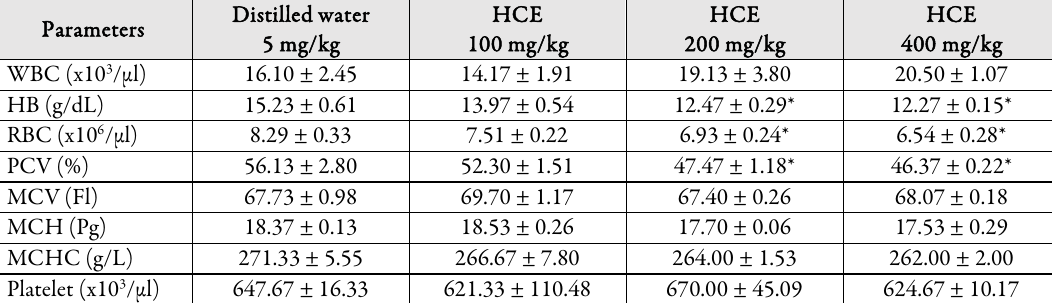
Table 3. Effects of HCE on hematological parameters of treated rats